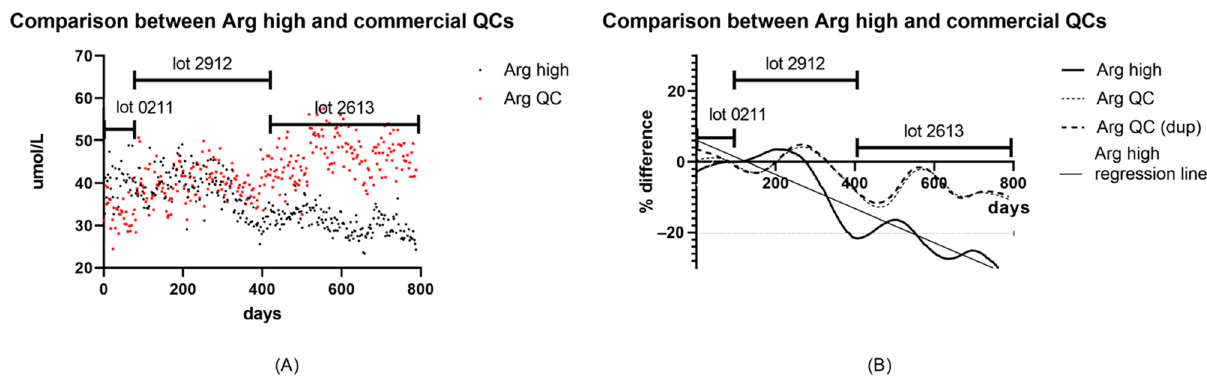
Figure 3. Comparison between consecutive measured values and percent difference of arginine high from NSQAP QC material and commercial QCs. Consecutive values of arginine high (black) and commercial QCs (red) were scattered ( A ), and each whisker means the usage periods of each commercial QC. On the comparison between arginine high and commercial QCs ( B ), bold solid line, spotted line, dashed line, and thin sold line represented arginine high, duplicated commercial QCs, and the regression line of arginine, respectively. Each curve was smoothed using difference percentages between measured values and each initial means. The meeting point of curves of arginine high (bold solid line) and the regression line of arginine (thin sold line) at the around − 20% of di ff erence was approximately D542.